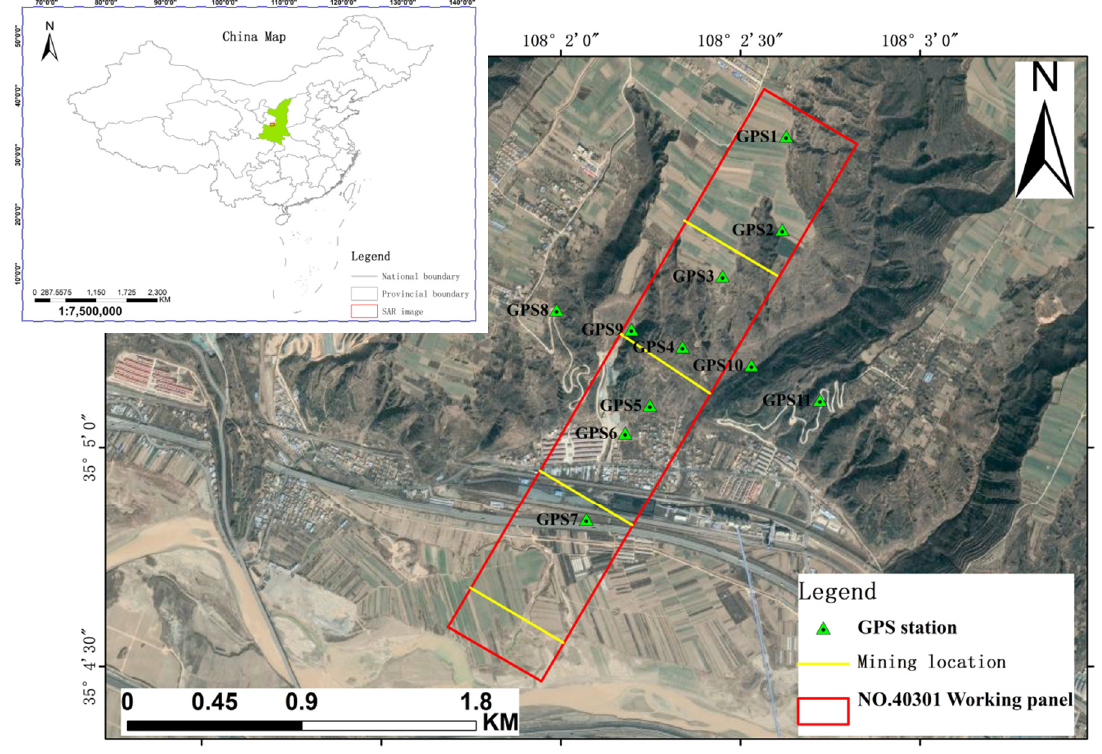
Figure 1. Geographical location of the NO.40301 working panel in Dafosi coal mine and Global Positioning System (GPS) stations with the corresponding Google Earth image as the background.